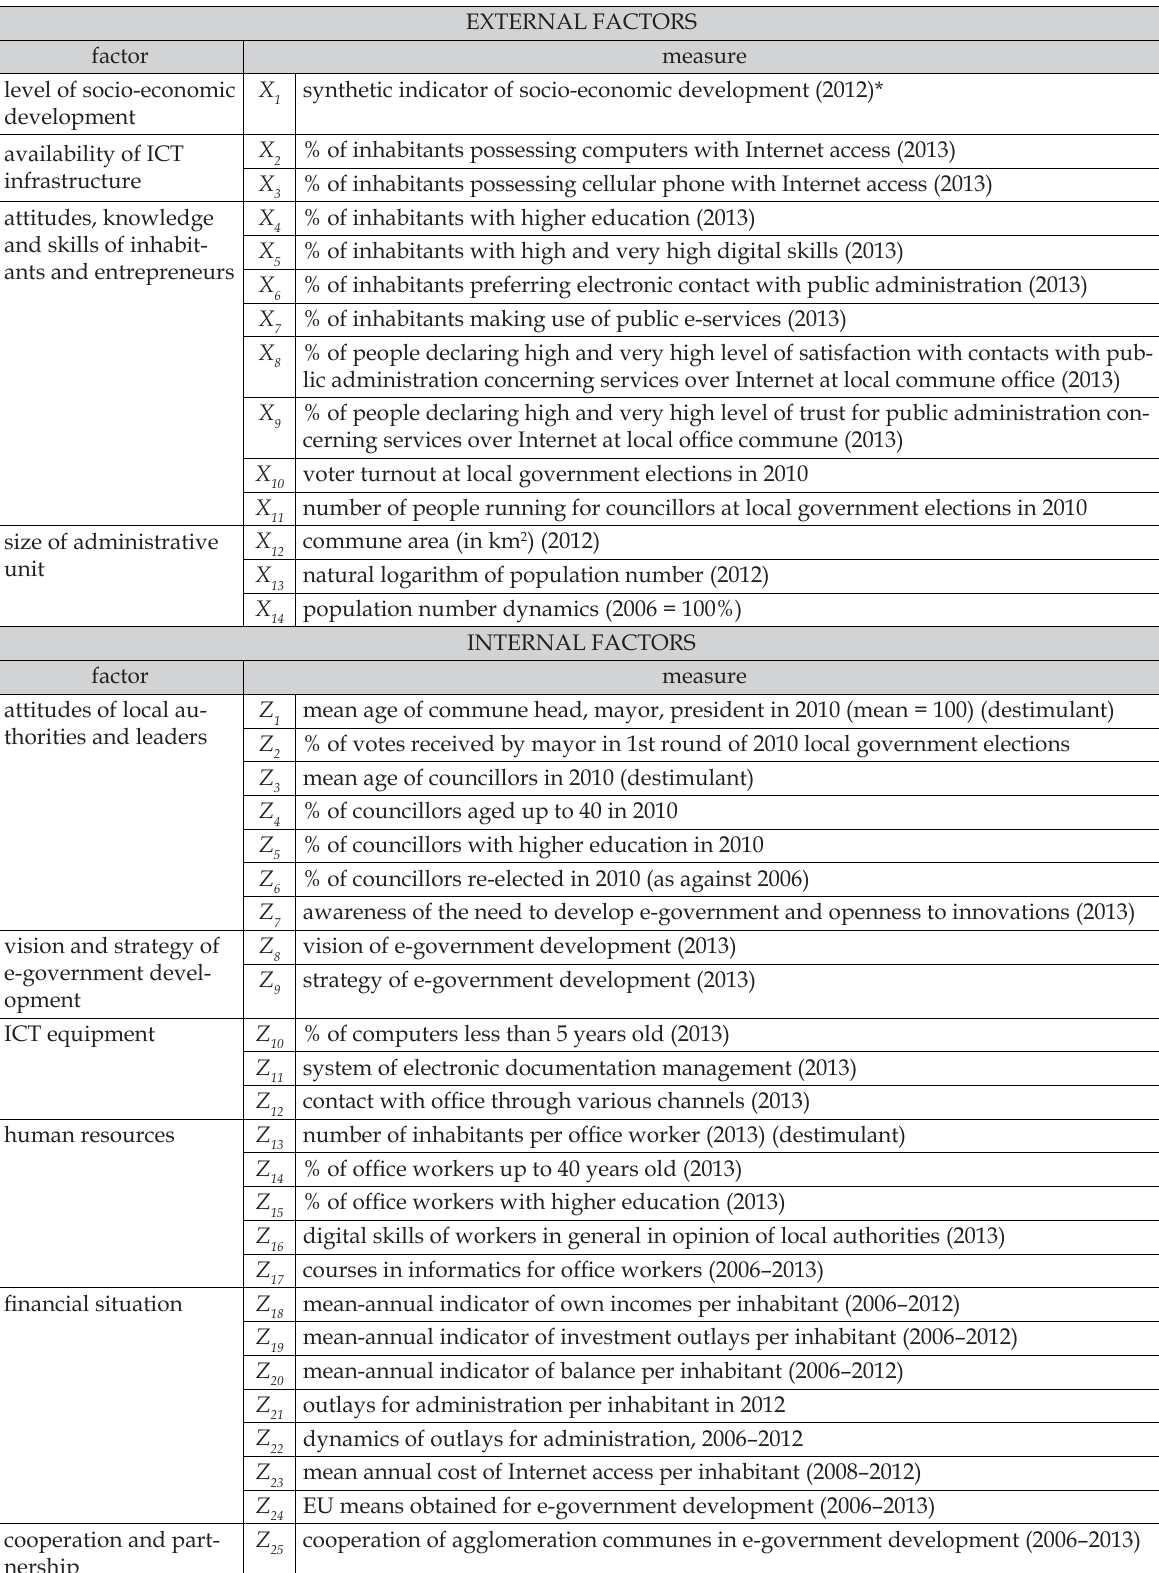
Table 1. Factors of local e-government development and their